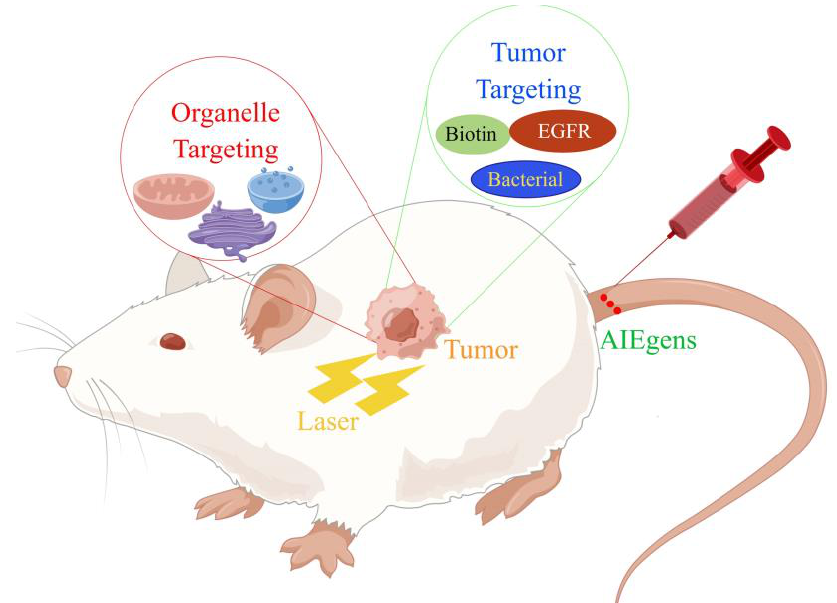
Figure 1. Different methods of treating tumor hypoxia.